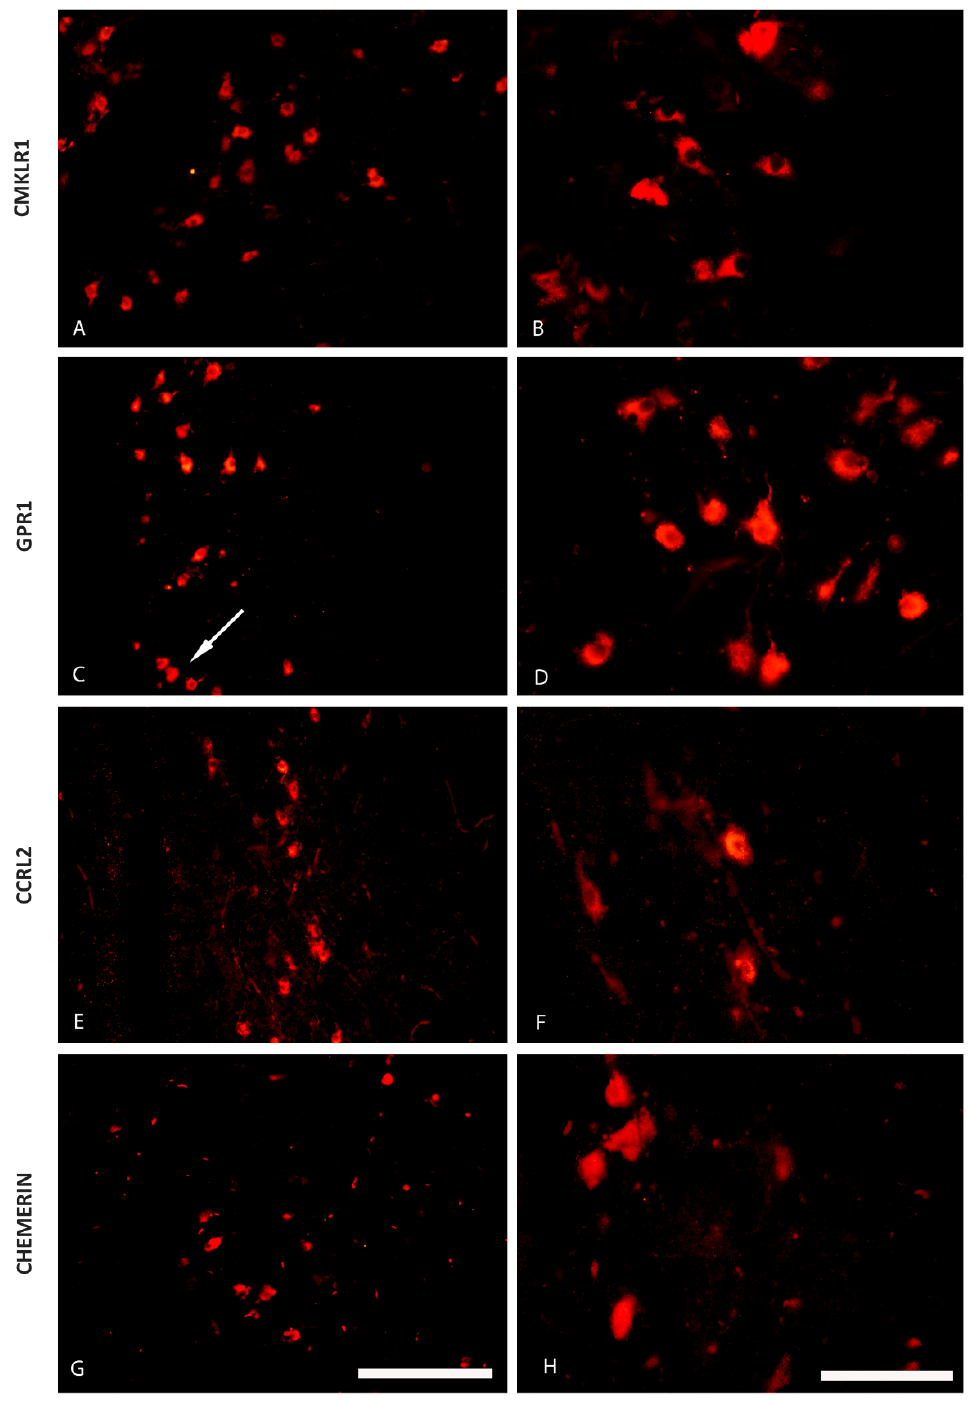
Figure 4. The distribution of the chemerin system in the porcine preoptic area (POA) during early pregnancy. Immunoreactivity of chemokine-like receptor 1 (CMKLR1; A and B ), G protein-coupled receptor 1 (GPR1; C and D ), C-C motif chemokine receptor-like 2 (CCRL2; E and F ) and chemerin ( G and H ) during early pregnancy (days 15 to 16) in the hypothalamus of the pig at the level of the preoptic area. The white arrow indicates the diagonal band of Broca. Scale bar: 200 µm, applies to A, C, E, G; scale bar: 100 µm, applies to B, D, F, H.